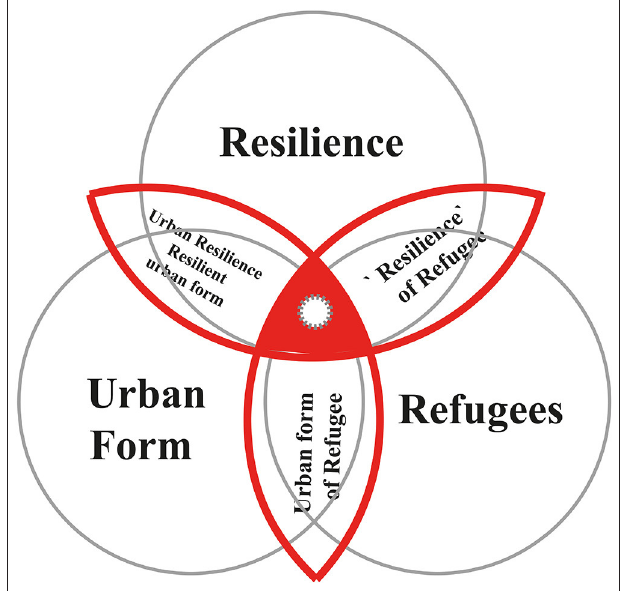
FIGURE 1 | The three research